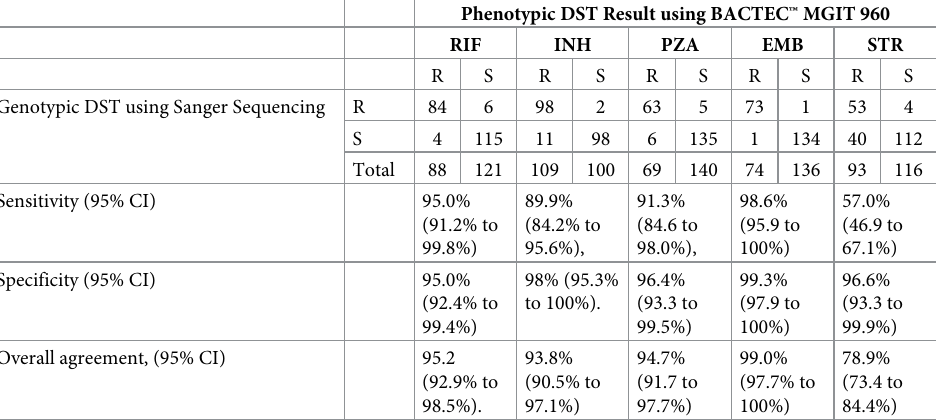
R: Resistance; S: Susceptible; CI: Confidence Interval. We investigated each drug by comparing the phenotype result of MGIT960 with the genotypic result of Sanger and sequencing and sensitivity specificity and accuracy are calculated as weighted means at 95%